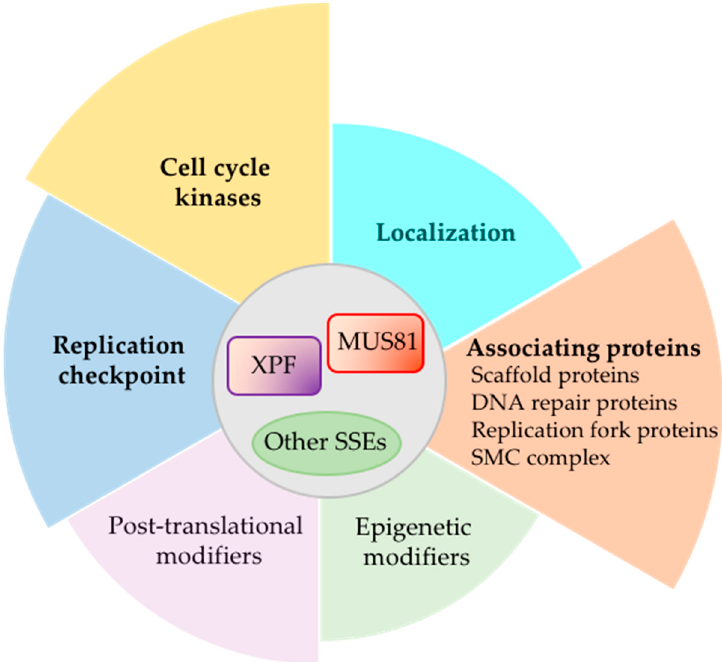
Figure 5. Summary of types of regulation of SSEs (MUS81 and XPF in particular) involved in resolving replication intermediates.